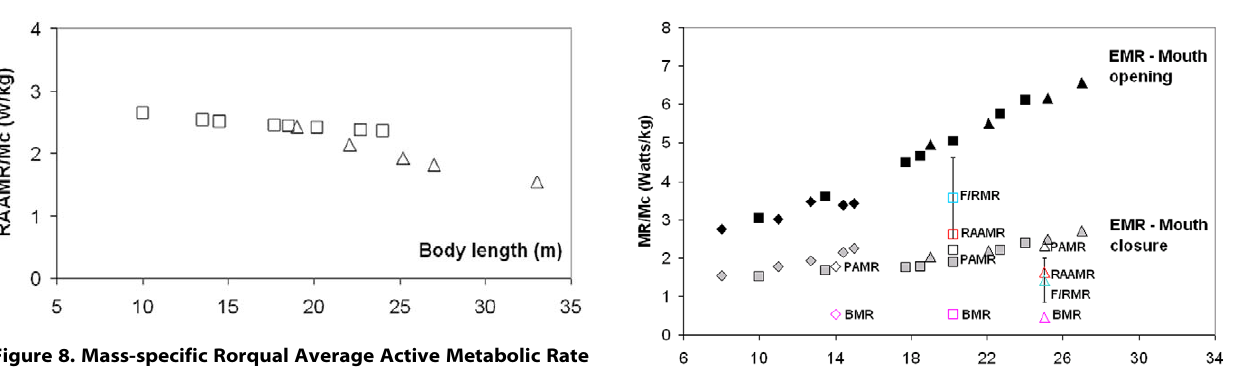
Figure 8. Mass-specific Rorqual Average Active Metabolic Rate (RAAMR), calculated for fin (squares) and blue whales (trian- gles). doi:10.1371/journal.pone.0044854.g008 Figure 9. Mass-specific Metabolic Rates (MR) across scale. Ratios